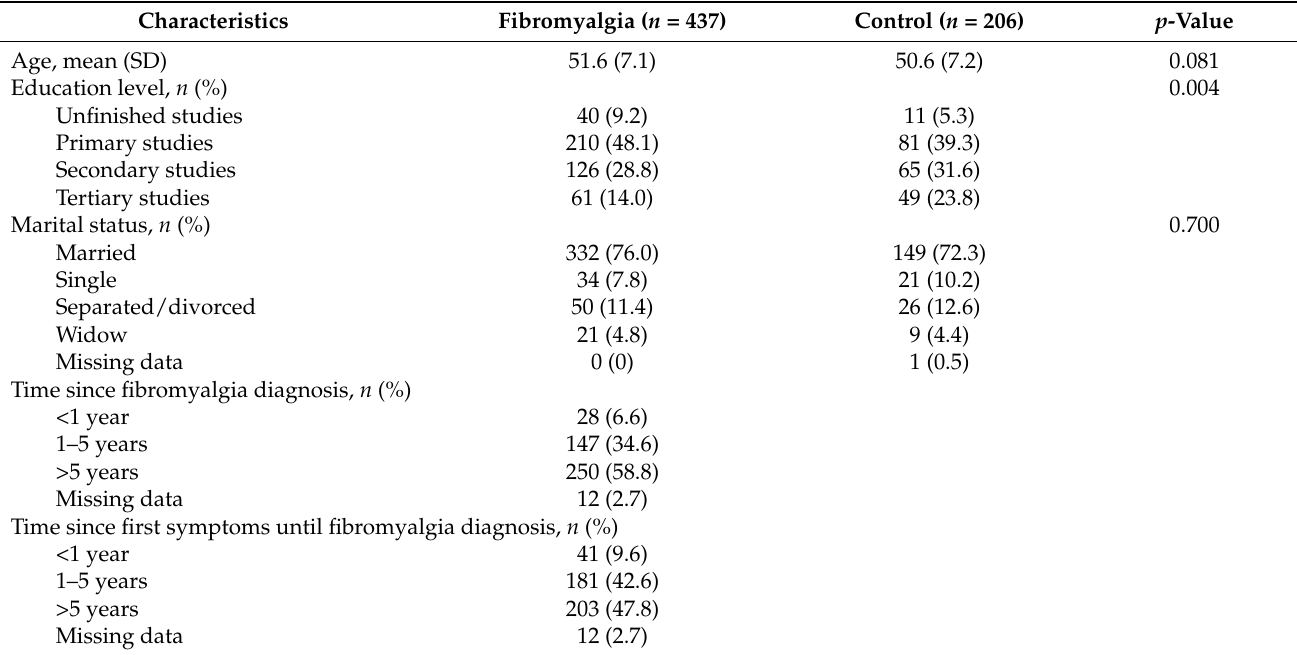
Table 1. Characteristics of the participants ( n =